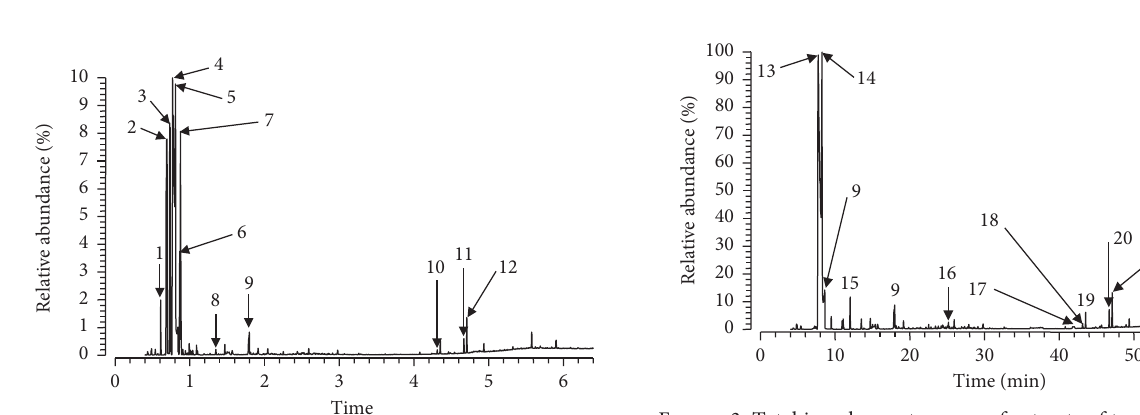
Figure 2: Total ion chromatograms of extracts of textile effluents A from the studied site. Peak numbers correspond to the chemical compounds indicated in Table 2.